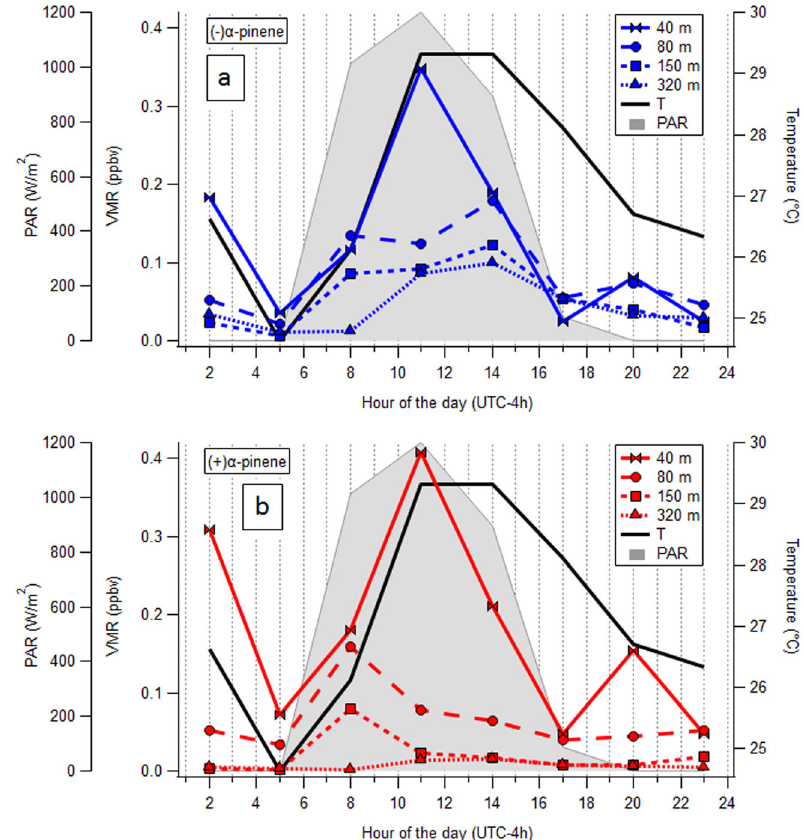
Fig. 3 Median values of ( − )- α -pinene (A) and ( + )- α -pinene (B) volume mixing ratios measured during the dry season. Incoming photosynthetic active radiation (PAR) and air temperature measured at 80 m at the neighbouring instant tower are shown with the gray shading and black line. Error bars indicating the 25 and 75 percentiles of the measurements taken at 80 m are shown in Fig.